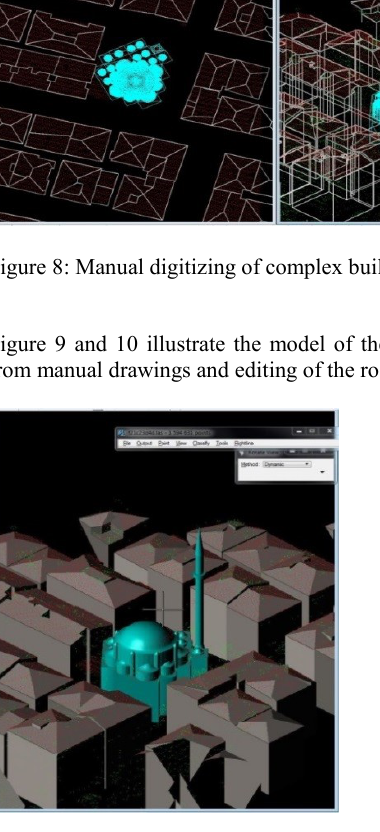
Figure 9: A mosque in LoD2 model (via manual technique)